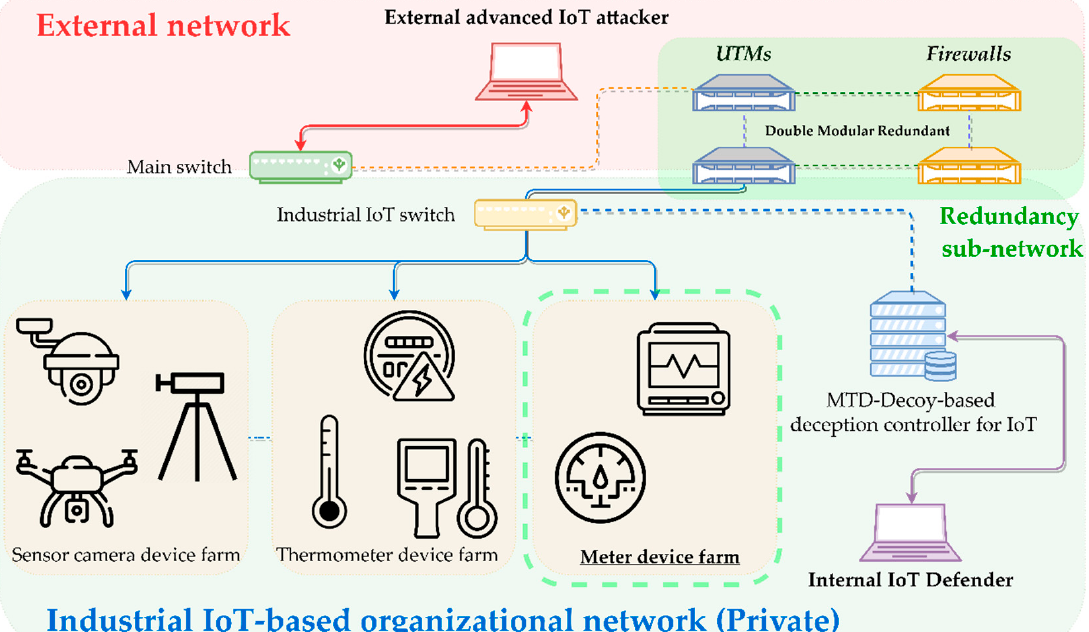
Figure 5. Overview of the industrial IoT-enabled topology with an organizational attack–defense strategy for Scenario 2.